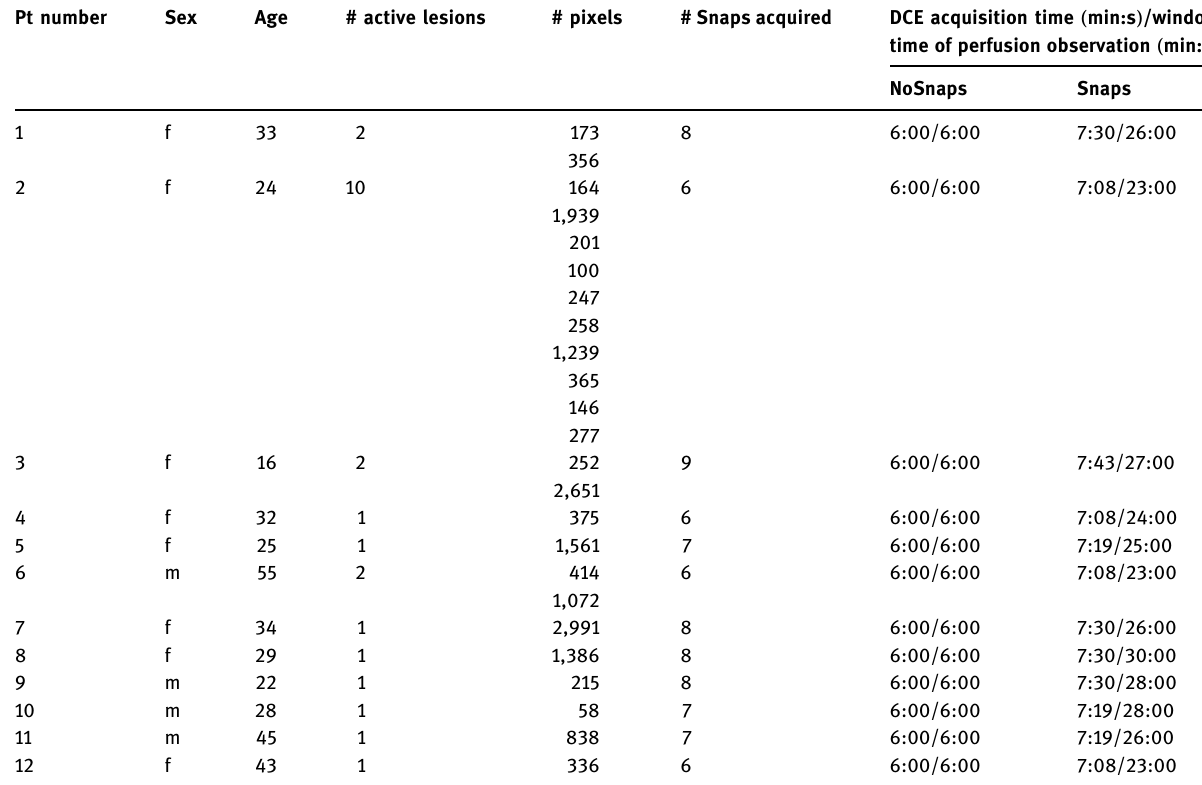
Table 1: Patient and protocol